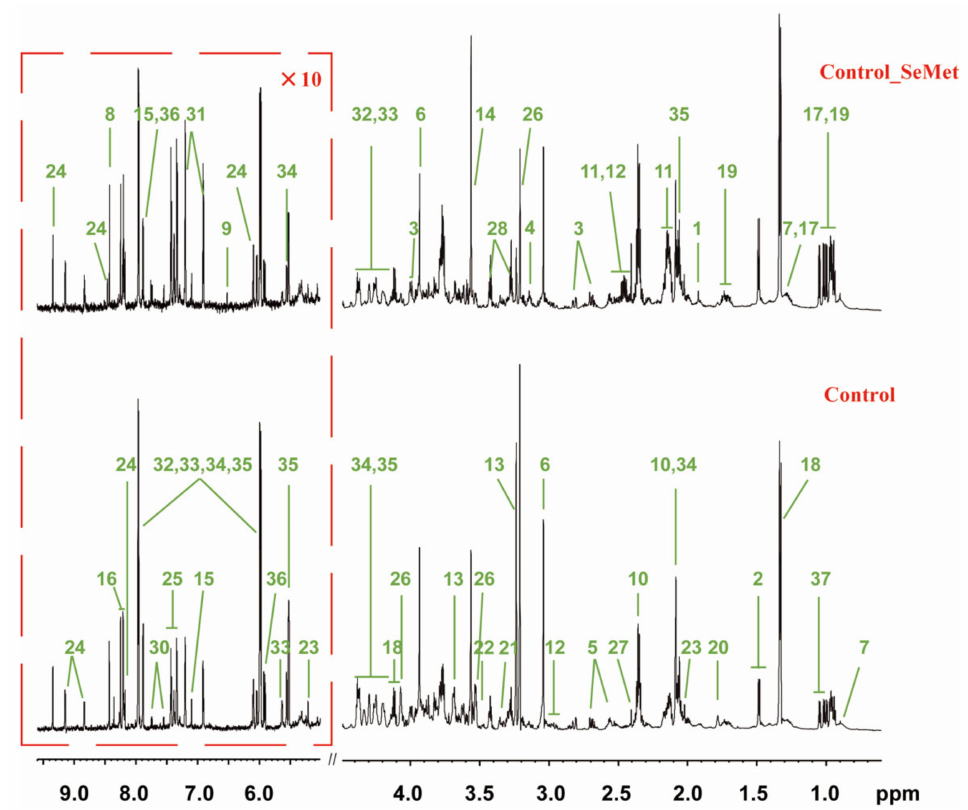
Figure 2. Typical 800 MHz 1 H NMR spectra of HepG2 cell extracts from control and control_SeMet groups. The Red dashed box is vertically expanded 10 times in the spectra. Keys: 1.